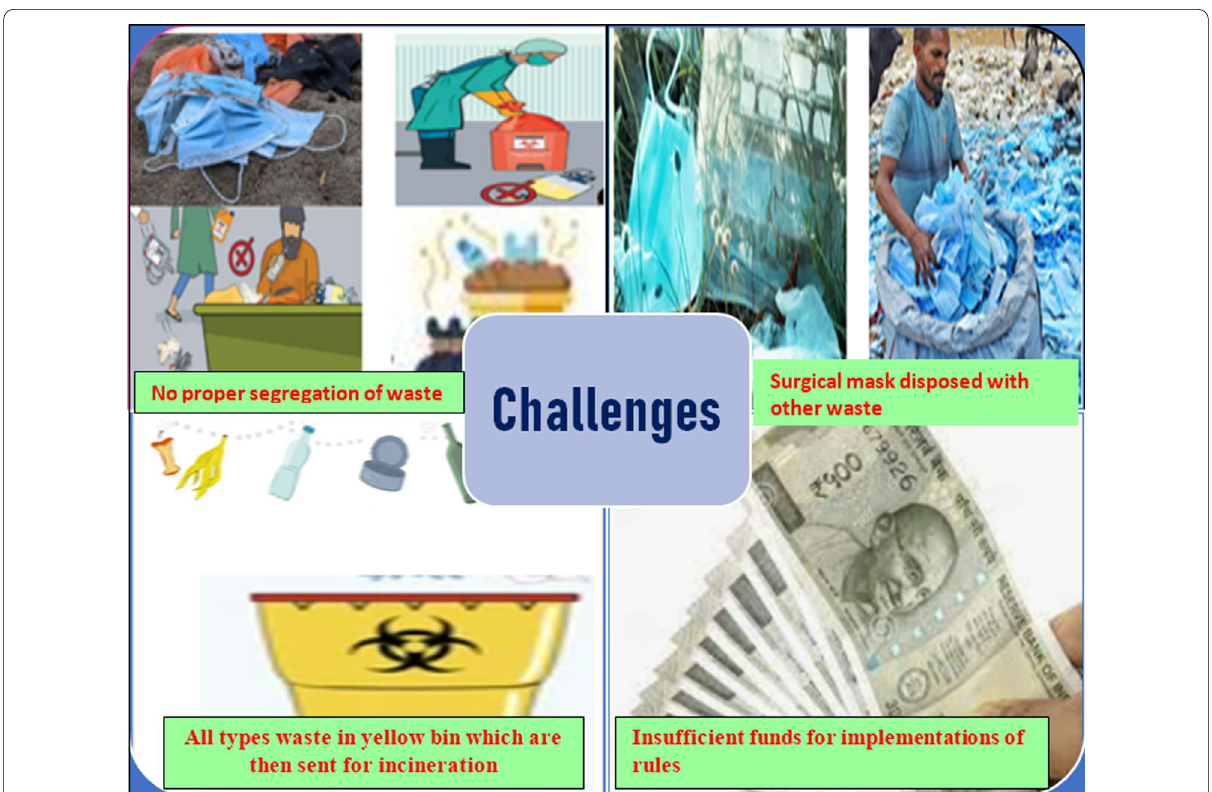
Fig. 5 Challenges in management of COVID-19 biomedical